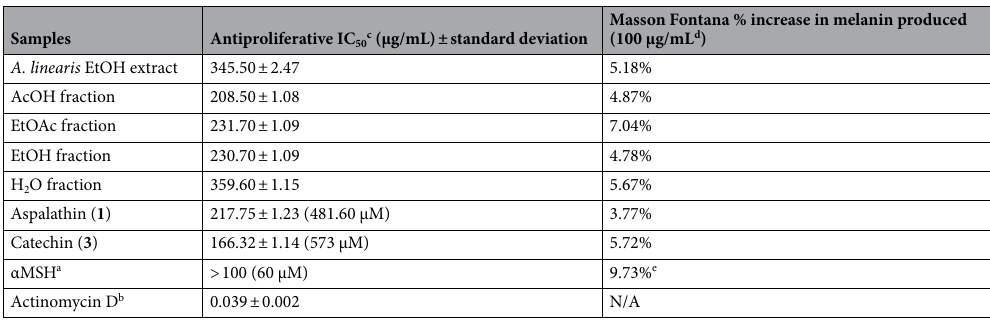
Table 5. Antiproliferative analysis against human melanocytes and the percentage melanin produced by the EtOH extract of Aspalathus linearis , its fractions and the compounds, exhibiting an increase in the tyrosinase enzyme rate. a Positive control for the Masson Fontana assay. b Positive control for the antiproliferative assay. c Concentration where 50% of the cells are viable. d Positive control tested at 30 µg/mL (18